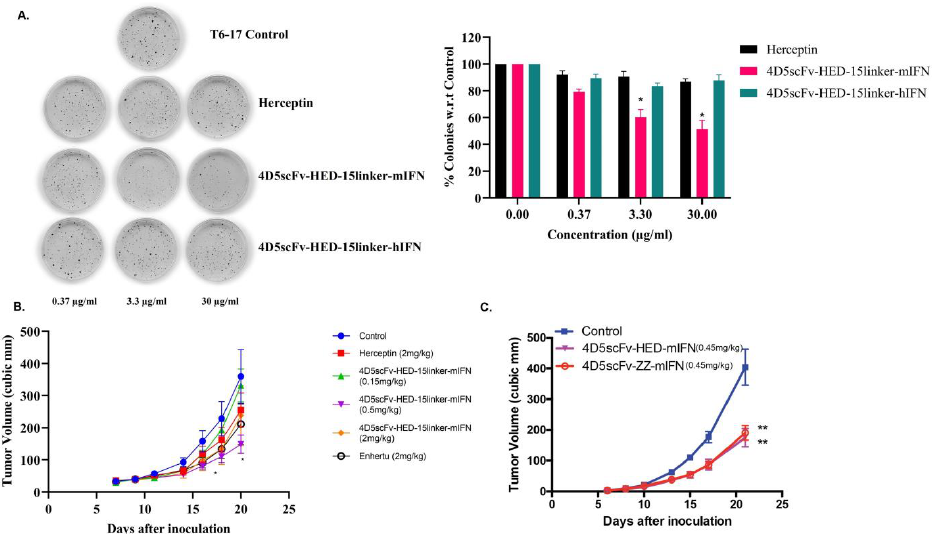
Figure 5. Functional characterization of HED engineered bodies in vitro and in vivo. ( A ) Colony formation assay against T6 - 17 cells using Herceptin, 4D5scFv - HED - 15 - linker - mIFN - γ and HED - 15 - linker - hIFN - γ, and Herceptin. Here, 4D5scFv - HED - 15 - linker - mIFN - γ shows dose - dependent cytotoxicity against T6 - 17 cells. ( B ) Targeted therapy of engineered antibodies (HED with 15 linker) against HER2 overexpressing murine CT26 cells. Enhertu is an antibody - drug conjugate (ADC) that targets HER2 and has been jointly developed and commercialized by Astra- Zeneca and Daiichi Sankyo. Mice were given treatment intraperitoneally every alternate day. The engineered protein 4D5 - scFv - HED - 15 - linker - m - IFN significantly reduces tumor volumes depicting the efficacy of this powerful new platform. ( C ) T6 - 17 cells were injected into athymic nude mice, and the latter were treated with 4D5scFv - HED - mIFN - γ or 4D5scFv - ZZ - mIFN - γ were provided to mice (0.45 mg/kg/dose) intraperitoneally. Significant reductions in tumor volumes were observed. Error bars represent the SEM. (* p < 0.05, ** p < 0.01).